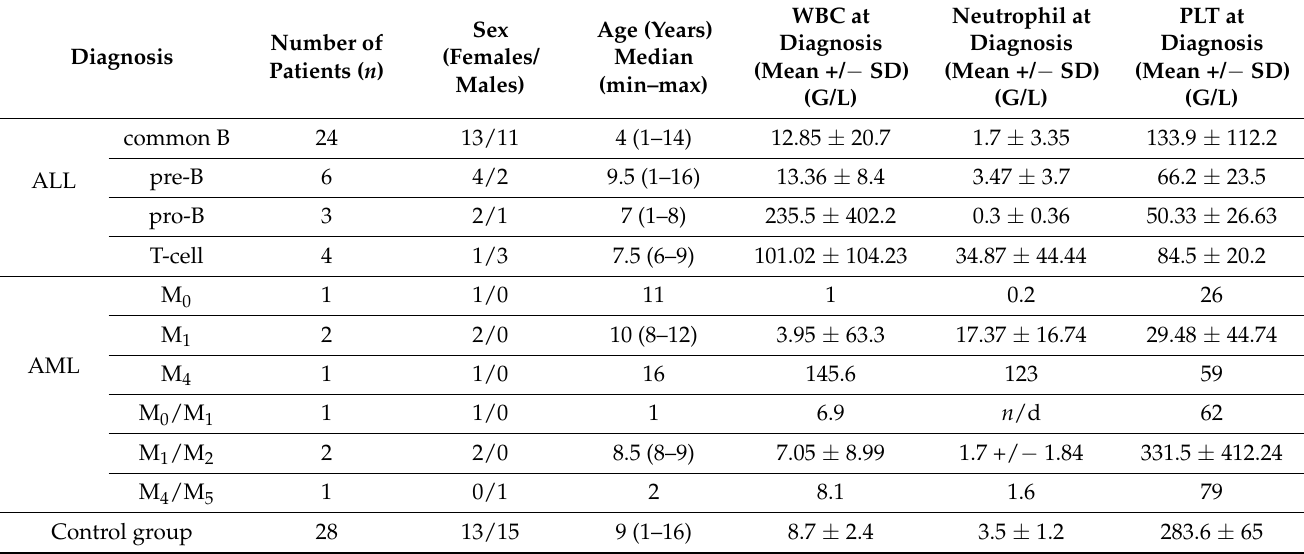
Table 2. Clinical characteristics of the study and control groups at